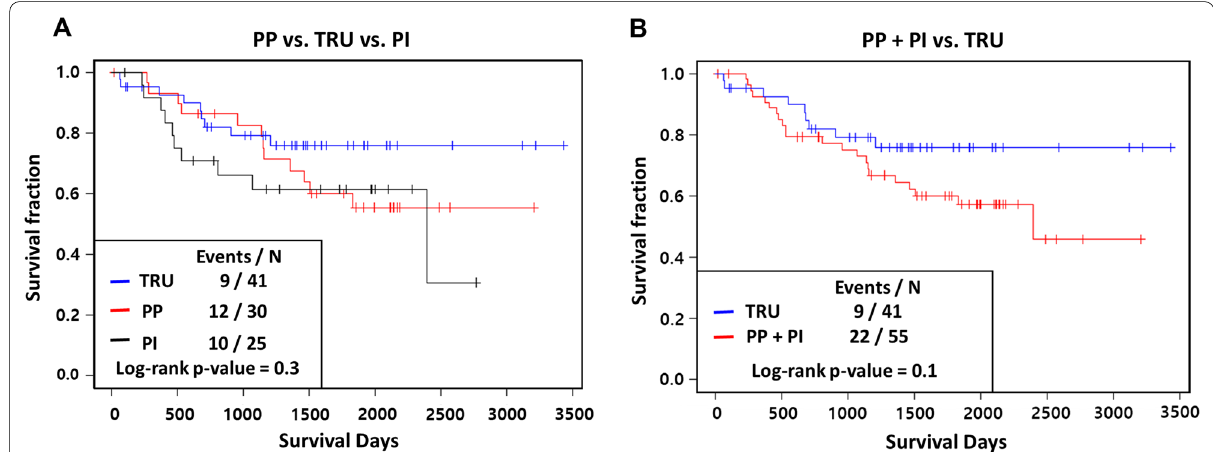
Fig. 5 Prognostic value of molecular subtypes: A overall survival Kaplan–Meier curves of each group divided by the molecular subtype, and B PP PI versus TRU. The boxes in each survival curve show the number of dead and the total number of patients for the groups and the p values + according to log‑rank